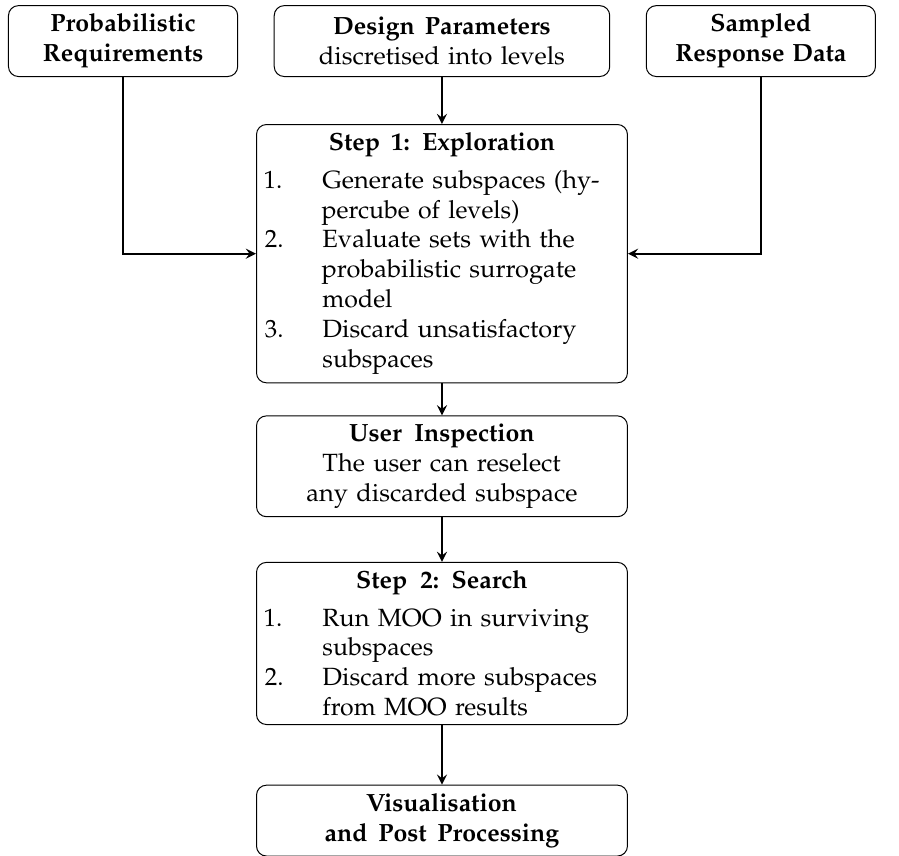
Figure 1. Flowchart of the proposed methodology.